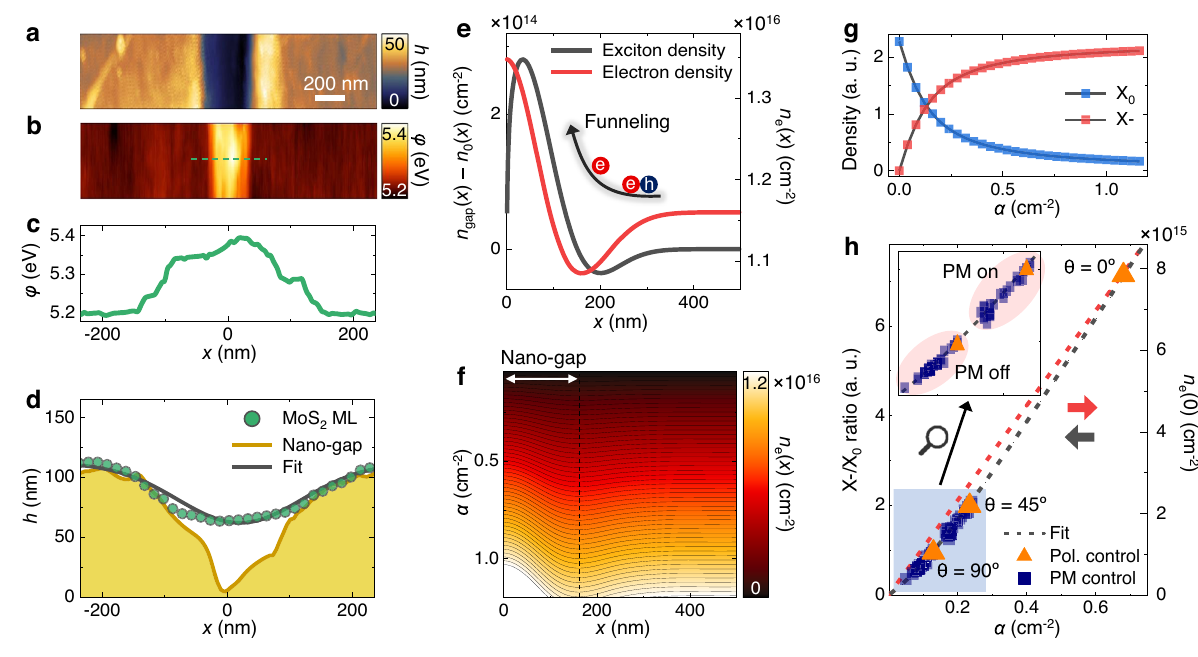
Fig. 5 | Theoretical investigation of electron funneling and exciton-to-trion conversion dynamics. Topography ( a ) and work function ( φ ) images ( b ) of waveguide obtained by KPFM. c Work function pro fi le derived from dashed green line in ( b ). d Height pro fi le of MoS 2 ML on nanogap of waveguide (green dots), fi tted line shape function (black line), and height pro fi le of nanogap without MoS ML(yellowline). e Spatialdensitydistributionofphotoexcitedexcitons(black)and electrons(red)understrainpro fi leestimatedfrom fi ttedline-shapefunctionin( d ). f Spatial electron density distribution as function of global defect density α for